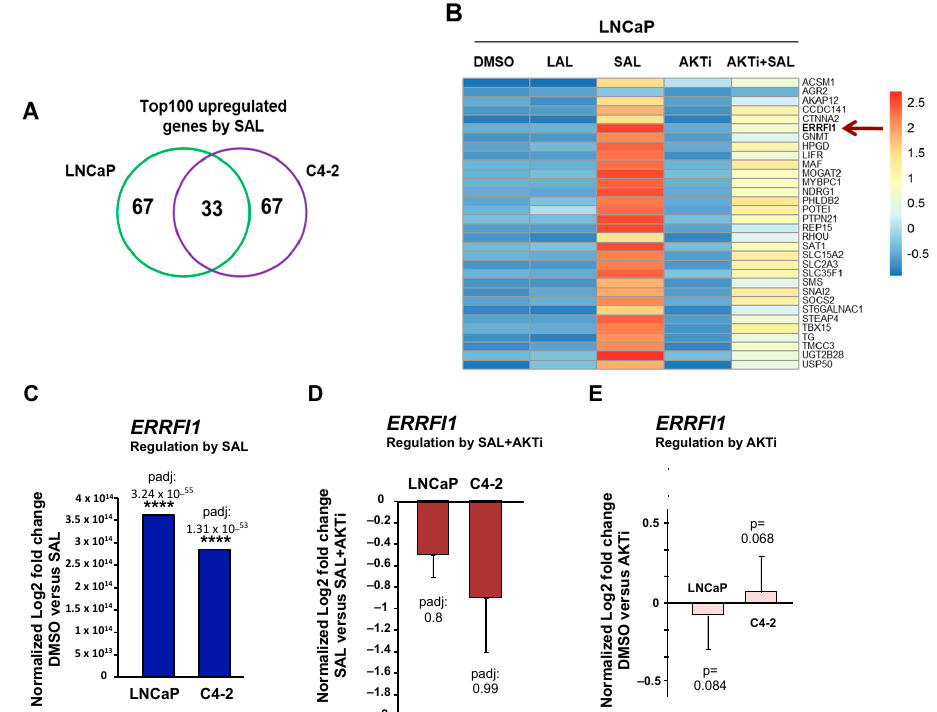
Figure 1. ERRFI1 expression is upregulated by SAL and inhibited by cotreatment with AKTi. Transcriptome analysis using RNA-seq were performed after treatment of cells for 72 h (n = 3). ( A ) Venn diagram indicates the overlap of the top100 significantly SAL-upregulated genes and their overlap between LNCaP and C4-2 cells. ( B ) Heat map represents the log2 fold change of the 33 genes upregulated upon SAL in LNCaP cells treated with DMSO as a solvent control, low androgen level (LAL, 1 pM R1881), supraphysiological androgen level (SAL, 1 nM R1881) and AKTi (1 µM). Color key number represents normalized count. ( C – E ) Normalized log2 fold change of ERRFI1 upon SAL ( C ), AKTi+SAL ( D ) or AKTi alone ( E ) in both LNCaP and C4-2 cells of RNA-seq data. One of the prominently induced genes is ERRFI1 , encoding MIG6 , being upregulated AKTi treatment itself did not affect the basal mRNA expression of ERRFI1 (Figure 1E).